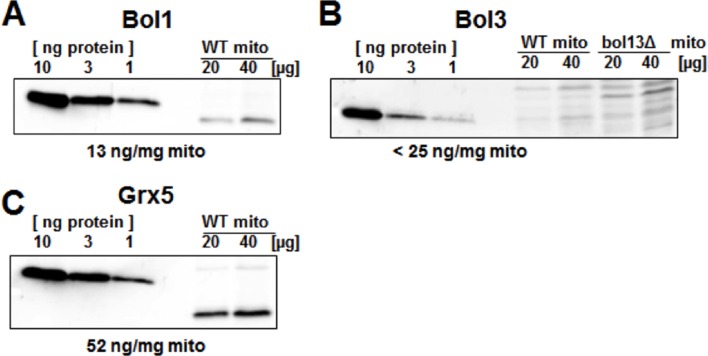
Protein levels of Bol1, Bol3 and Grx5 in yeast mitochondria.Wild-type (WT; BY4742) and bol13Δ cells were grown in minimal medium containing 2% galactose supplemented with 50 µM ferric ammonium citrate and used for isolation of mitochondria (mito). Mitochondrial proteins and the indicated amounts of purified (A) Bol1, (B) Bol3, and (C) Grx5 were analyzed by immunostaining with specific antibodies. Densitometry of the bands was used to calculate the proteins levels (in ng per mg mitochondria). Since our antibody did not detect wild-type amounts of Bol3 in mitochondria (B), only an upper limit of Bol3 could be calculated. The different gel mobility of purified and mitochondrial Bol1 and Grx5 is explained by a His-tag on purified proteins.